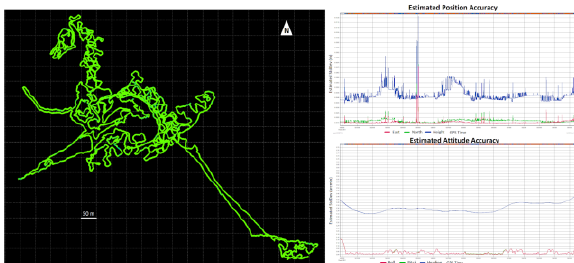
Figure 3. Left: The post-processing result of the full trajectory for the thaw slump data. The extent of the area is about 1.3 km by 0.8 km, elevation difference was 140 m, and it took 4 hours 23 minutes to collect. Right: Estimated position (top) and attitude (bottom) standard deviations show stable solution.